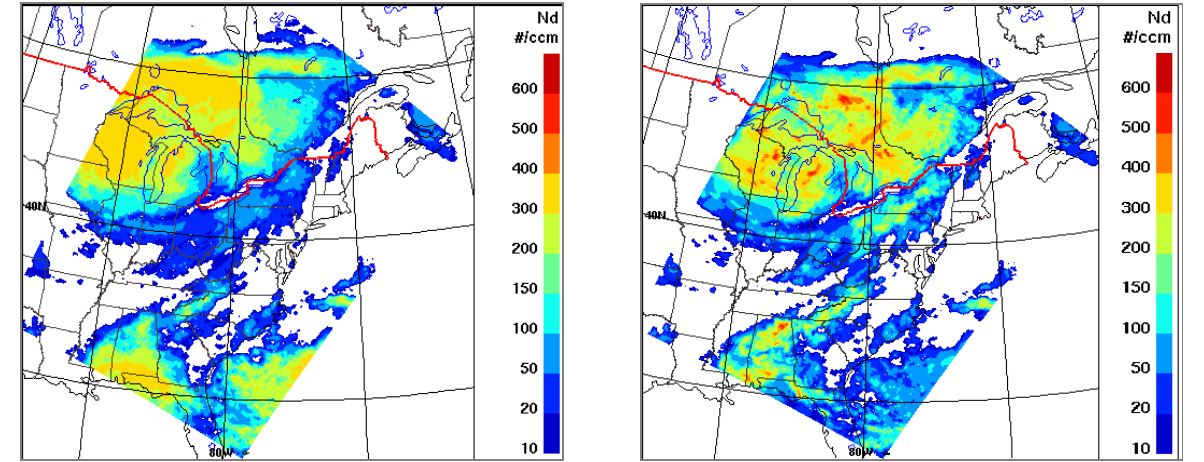
Figure 1. Modeled droplet number concentration, 24-h average on 10 August 2004, at 1235 m: left panel—Jones scheme, right panel—Abdul-Razzak & Ghan